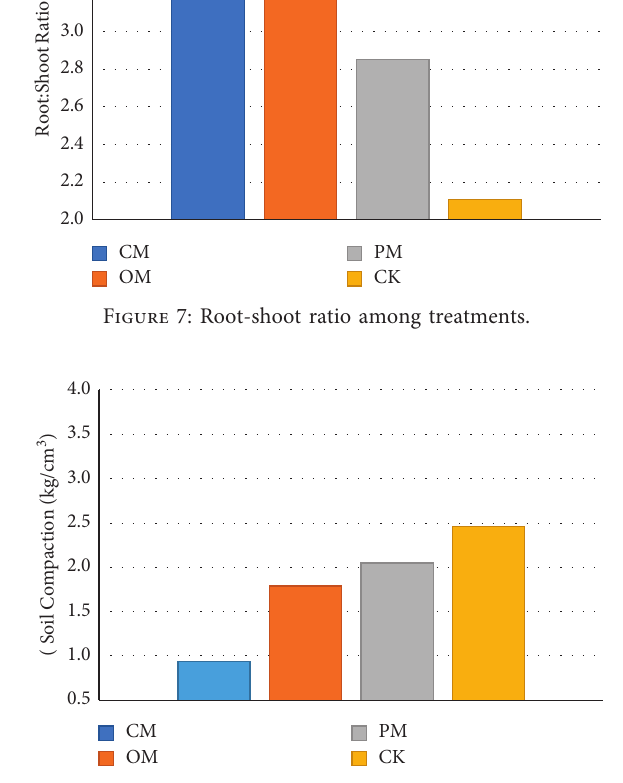
Figure 8: Soil compaction under different mulching.